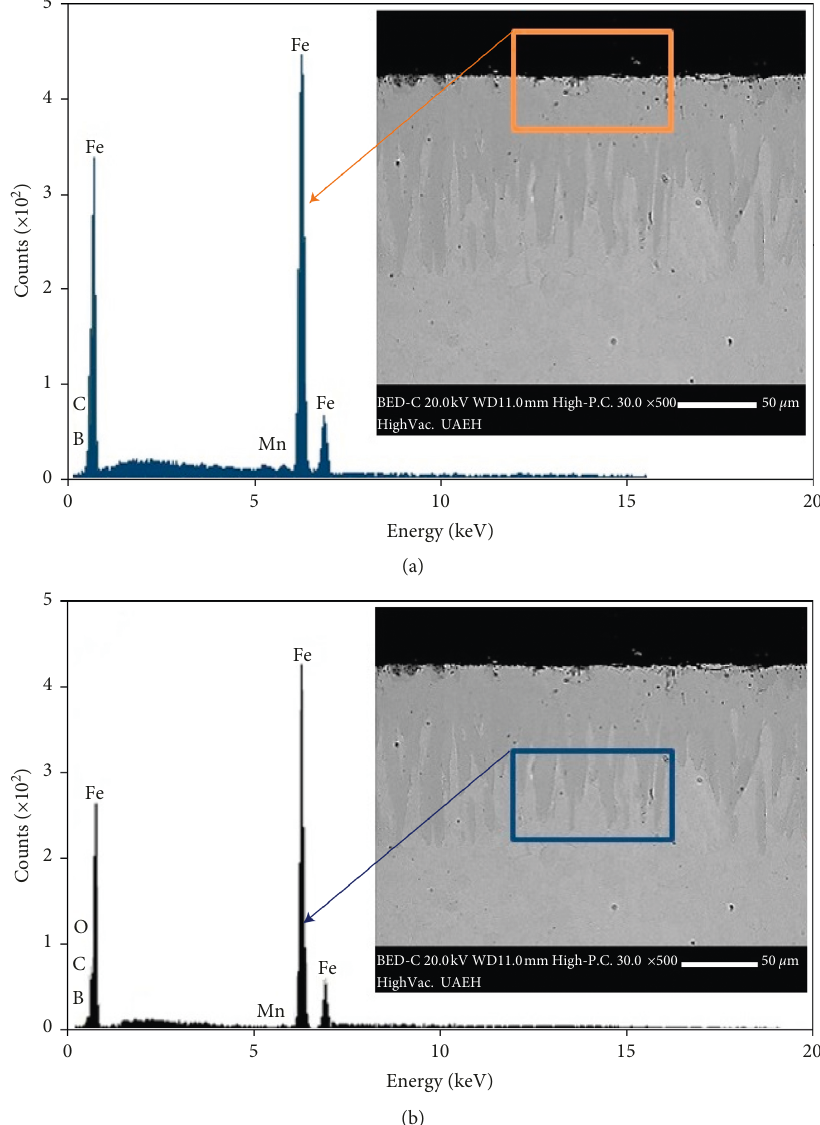
Figure 5: SEM micrograph of the cross sections of the borided ASTM A36 steel micrograph image of microstructure of the ASTM A36 boride layer obtained at 1123K with exposure time of 8h (a) and (b) EDS analysis on cross section of the borided sample.